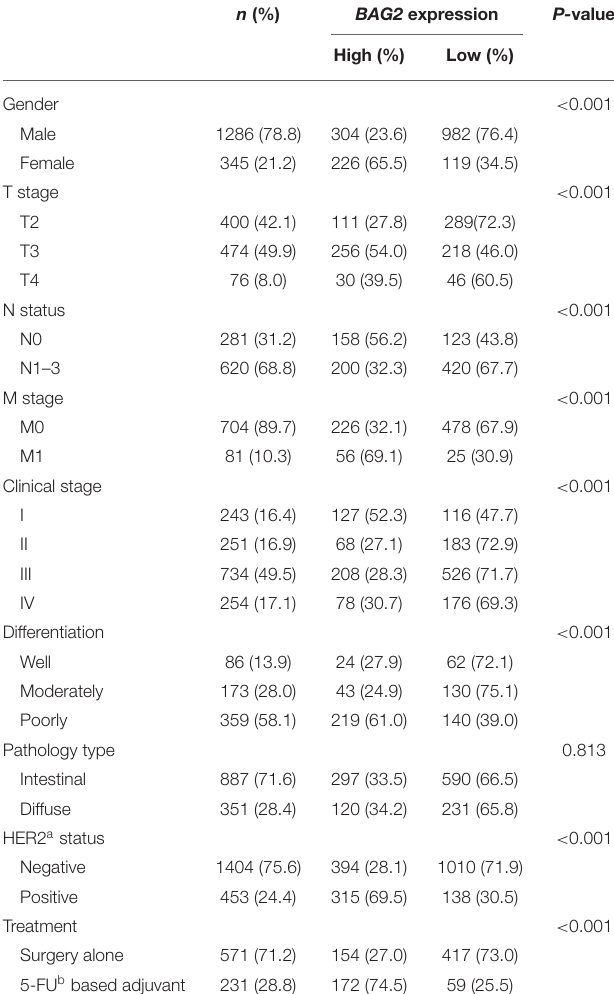
features of gastric patients from KM-plotter. n (%) BAG2